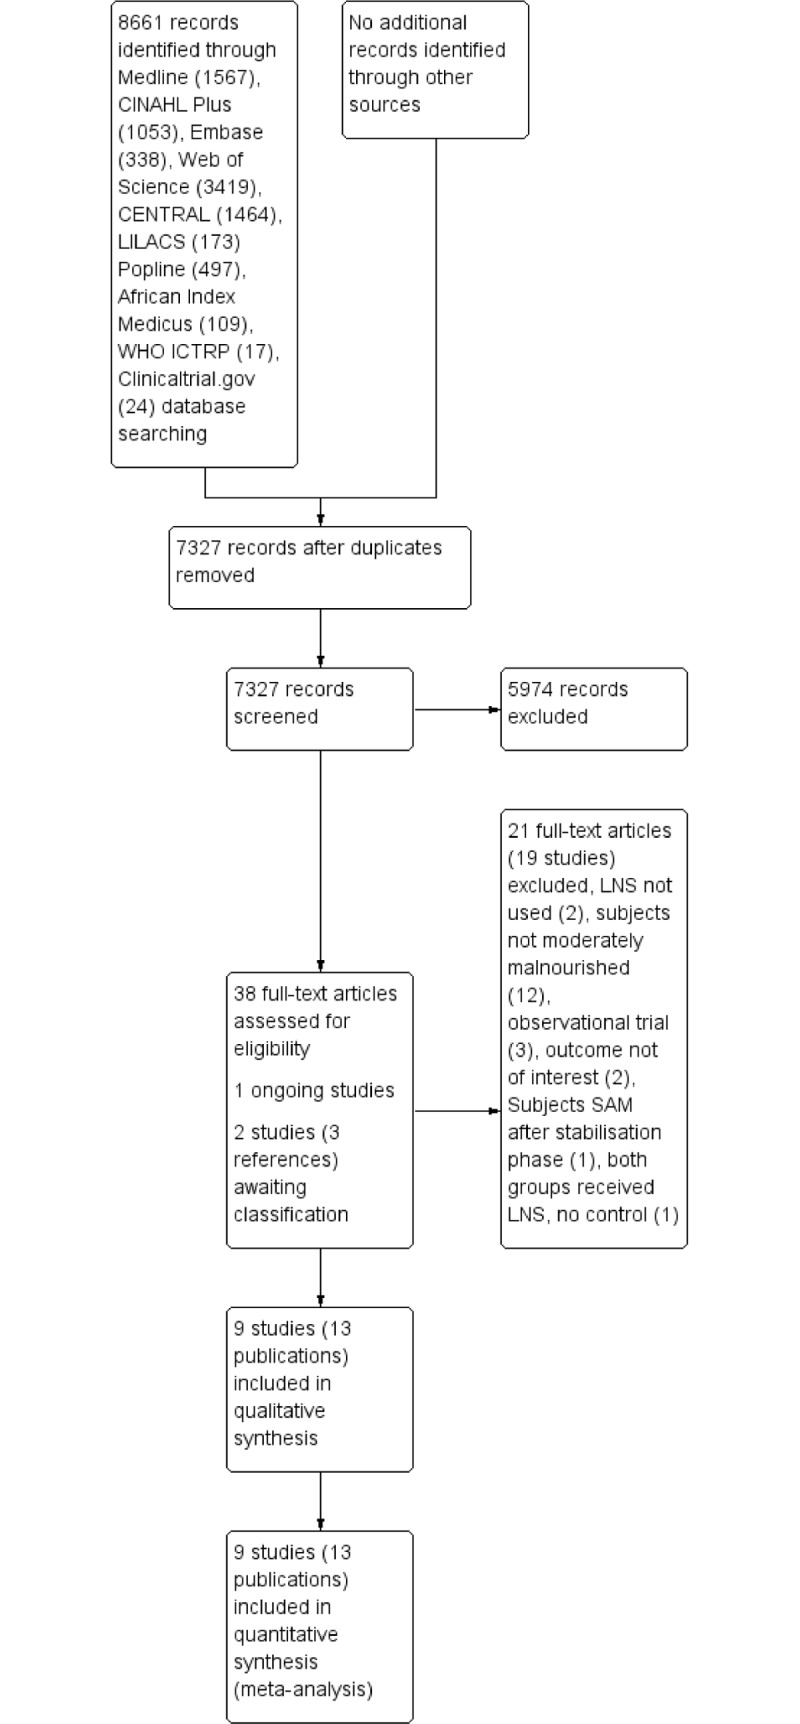
Study flow diagram.